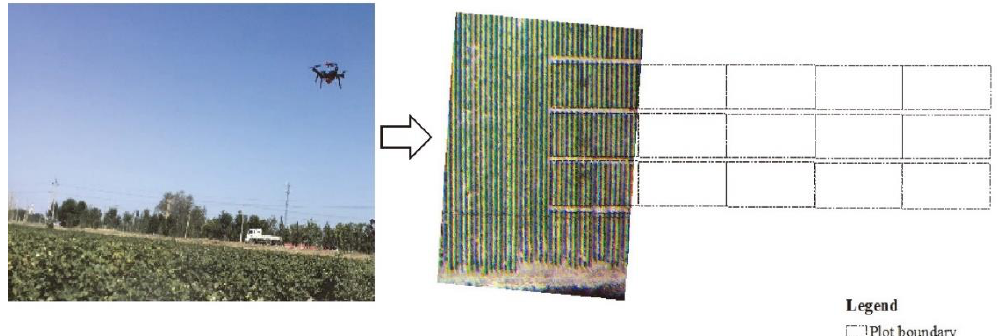
Figure 2. Unmanned aerial vehicle platform with one acquired image.